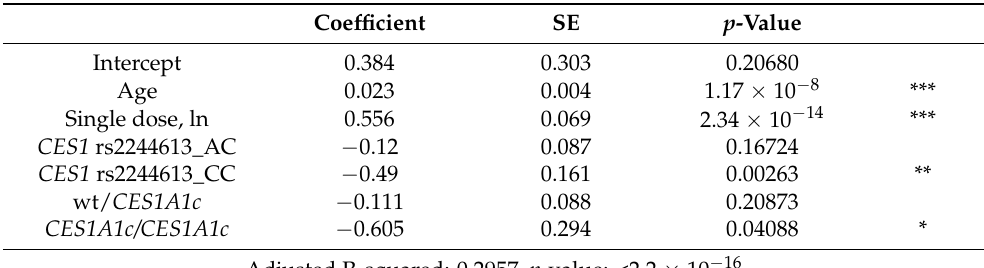
Table 4. Linear regression analysis on trough enalaprilat